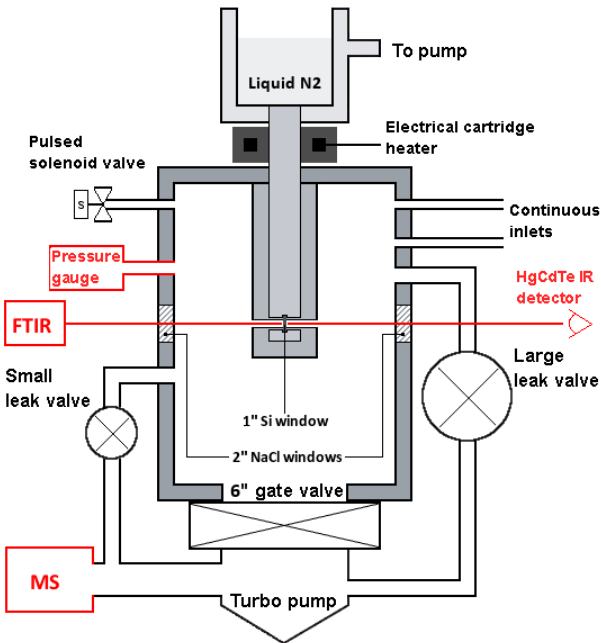
Figure 1. Schematic drawing of the reactor used in this work. The diagnostic tools are highlighted in red, and important parameters are listed in Tables 1 and 2. The ice film is deposited on both sides of the 1” diameter Si window (black vertical symbol hanging from cryostat inside reaction